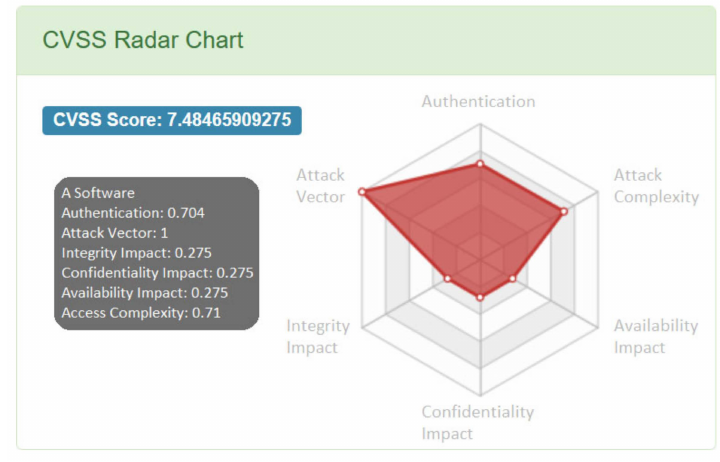
Figure 4. Example of IVD CVSS score radar, reproduced from